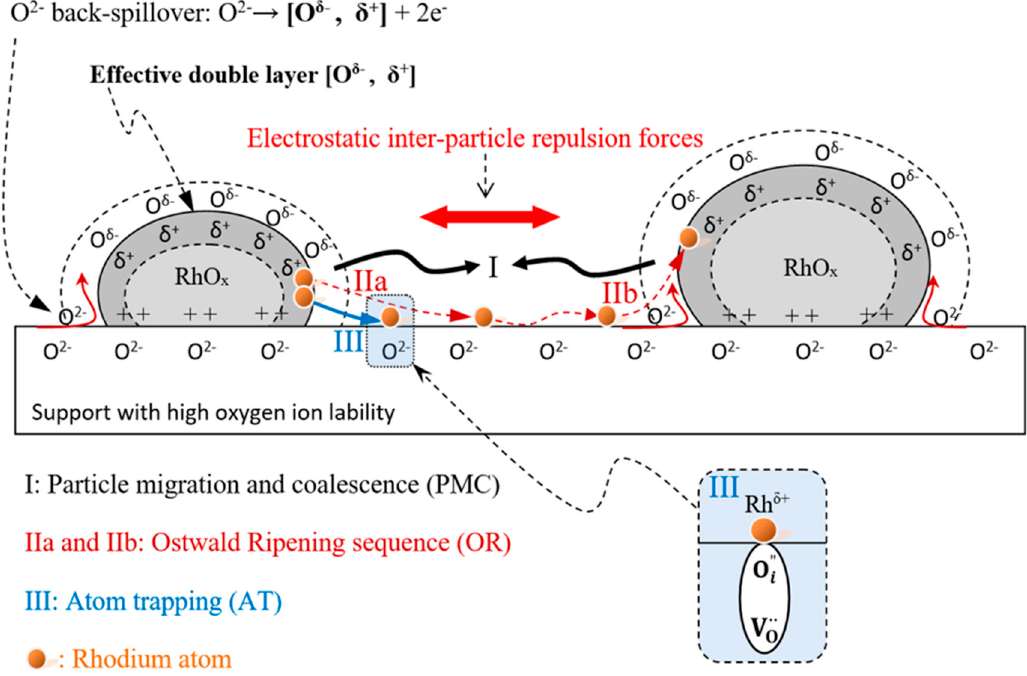
Figure 8. Model for sintering resistance against PMC or OR and redispersion induced by the simultaneous action of interparticle repulsion forces arising from effective double layer and atom trapping at oxygen ion vacancies. (O (cid:48)(cid:48) is the Krönger–Vink notation for interstitial (labile) O 2 − ; their concentration is determined by the equilibrium O O ↔ V between lattice oxygen and oxygen ion vacancies [43]).